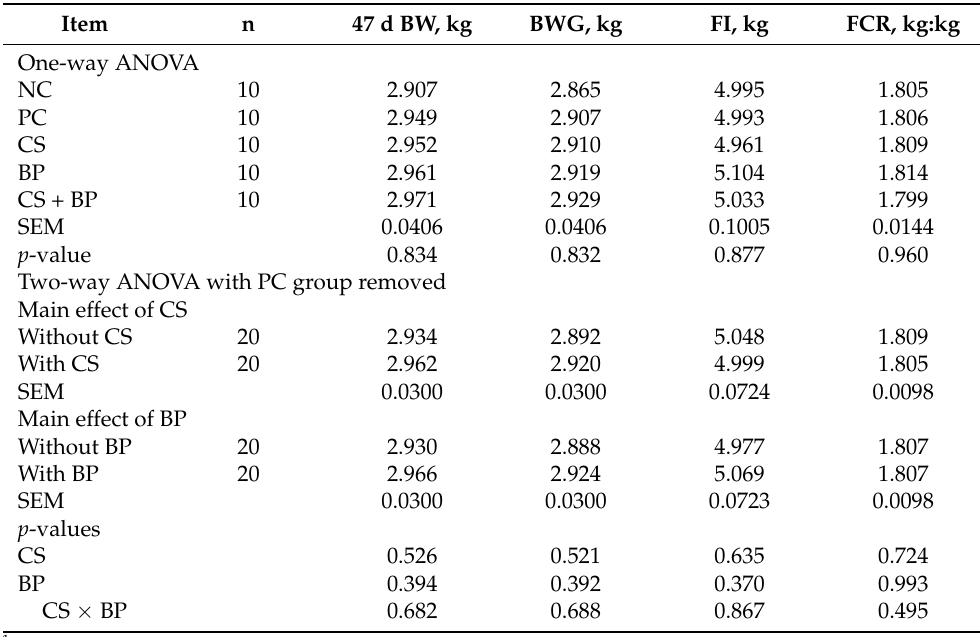
Table 4. Live performance of broilers fed diets with and without bacitracin methylene disalicylate or various antibiotic alternatives from 0 to 47 d post-hatch 1 . Item